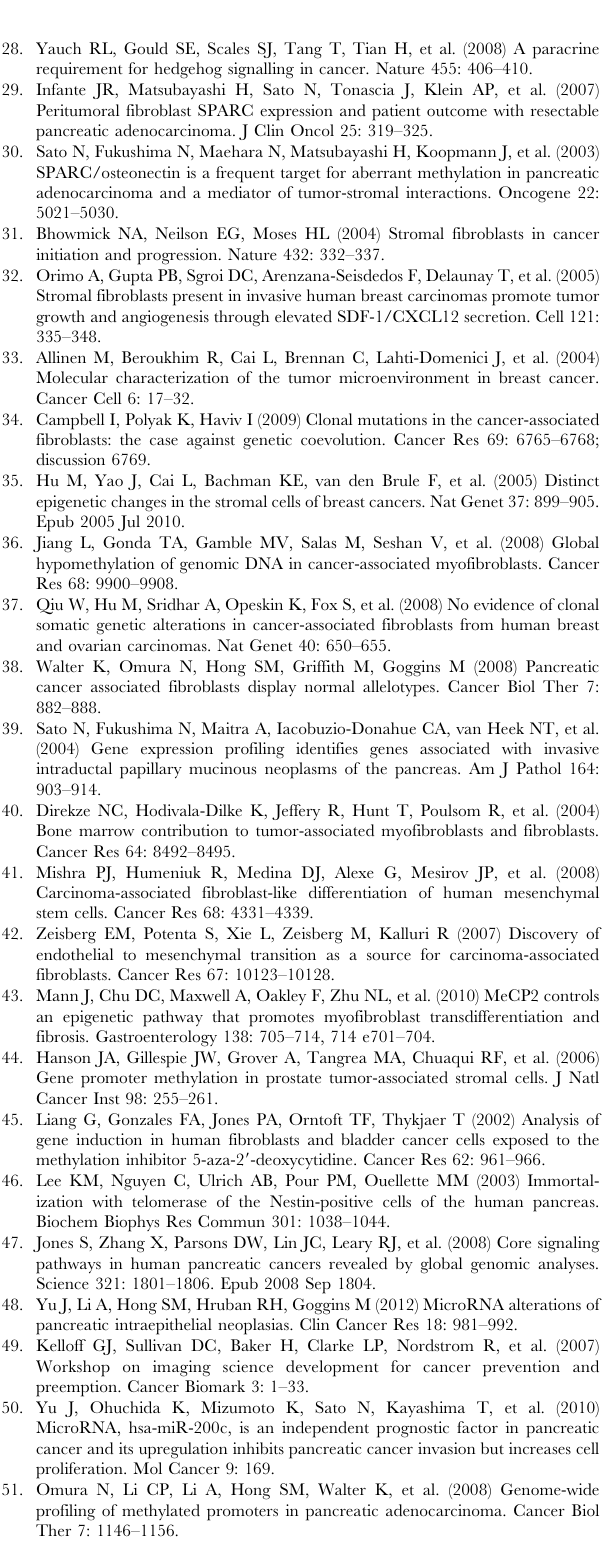
Table S2 Candidate hypermethylated genes underexpressed in CAFs relative to control